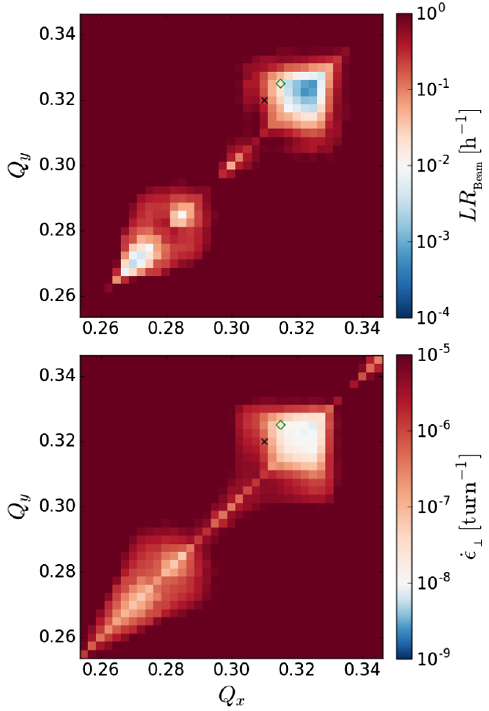
FIG. 7. Scan in ð Q x ; Q y Þ space, for Δ Q β (cid:1) 40 cm, ϕ 0 . 9 and Q 0 ¼ 15 . At the working points ϕ 0 . 03 , q ¼ PIW ¼ Tot ð PIW Þ ¼ marked by blue squares with white crosses, the entire beam was lost before the long-term loss rate could be calculated. The green diamond ( ) marks a suggested working point in this tune area, ð Q x ; Q y Þ ¼ ð 0 . 475 ; 0 . 485 Þ